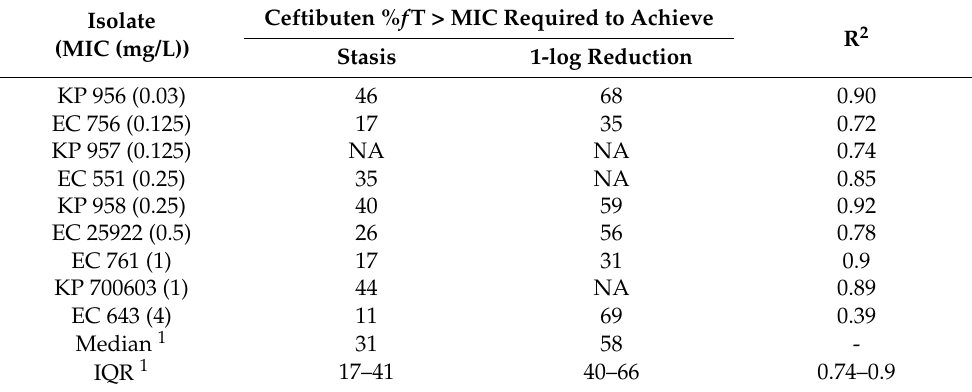
Figure 2. In vivo antibacterial activity of the ceftibuten human-simulated regimen (300 mg taken orally every 8 h) compared to the 0 h and 24 h control groups. Table 3. % f T > MIC pharmacodynamic targets for ceftibuten against individual isolates and the aggregate